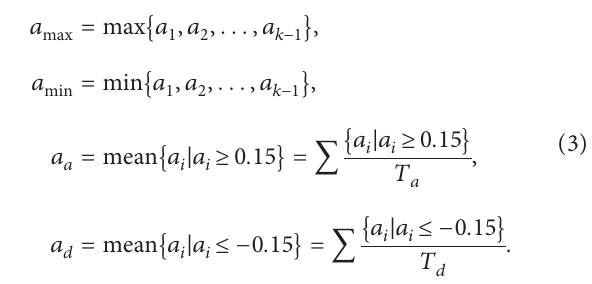
Table 1: Feature parameters for the division of kinematic